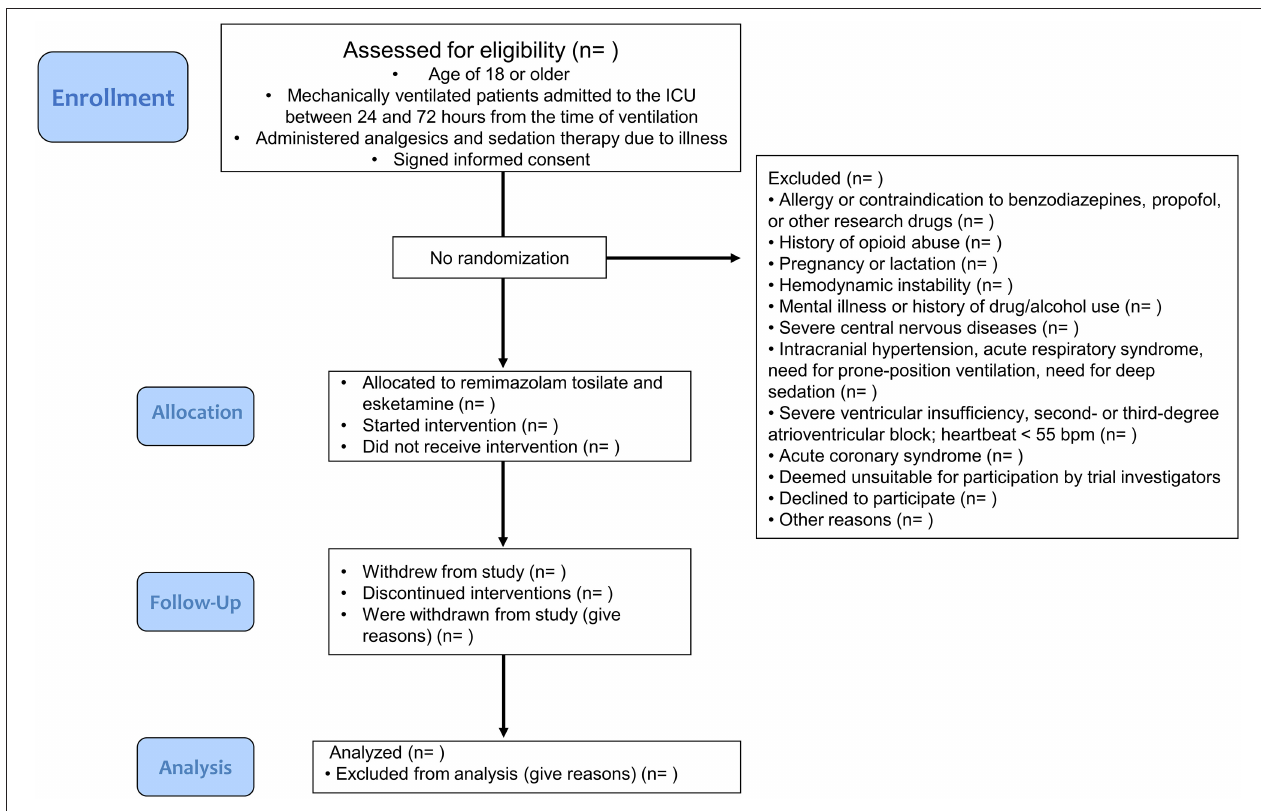
FIGURE 1 | Flow chart of study